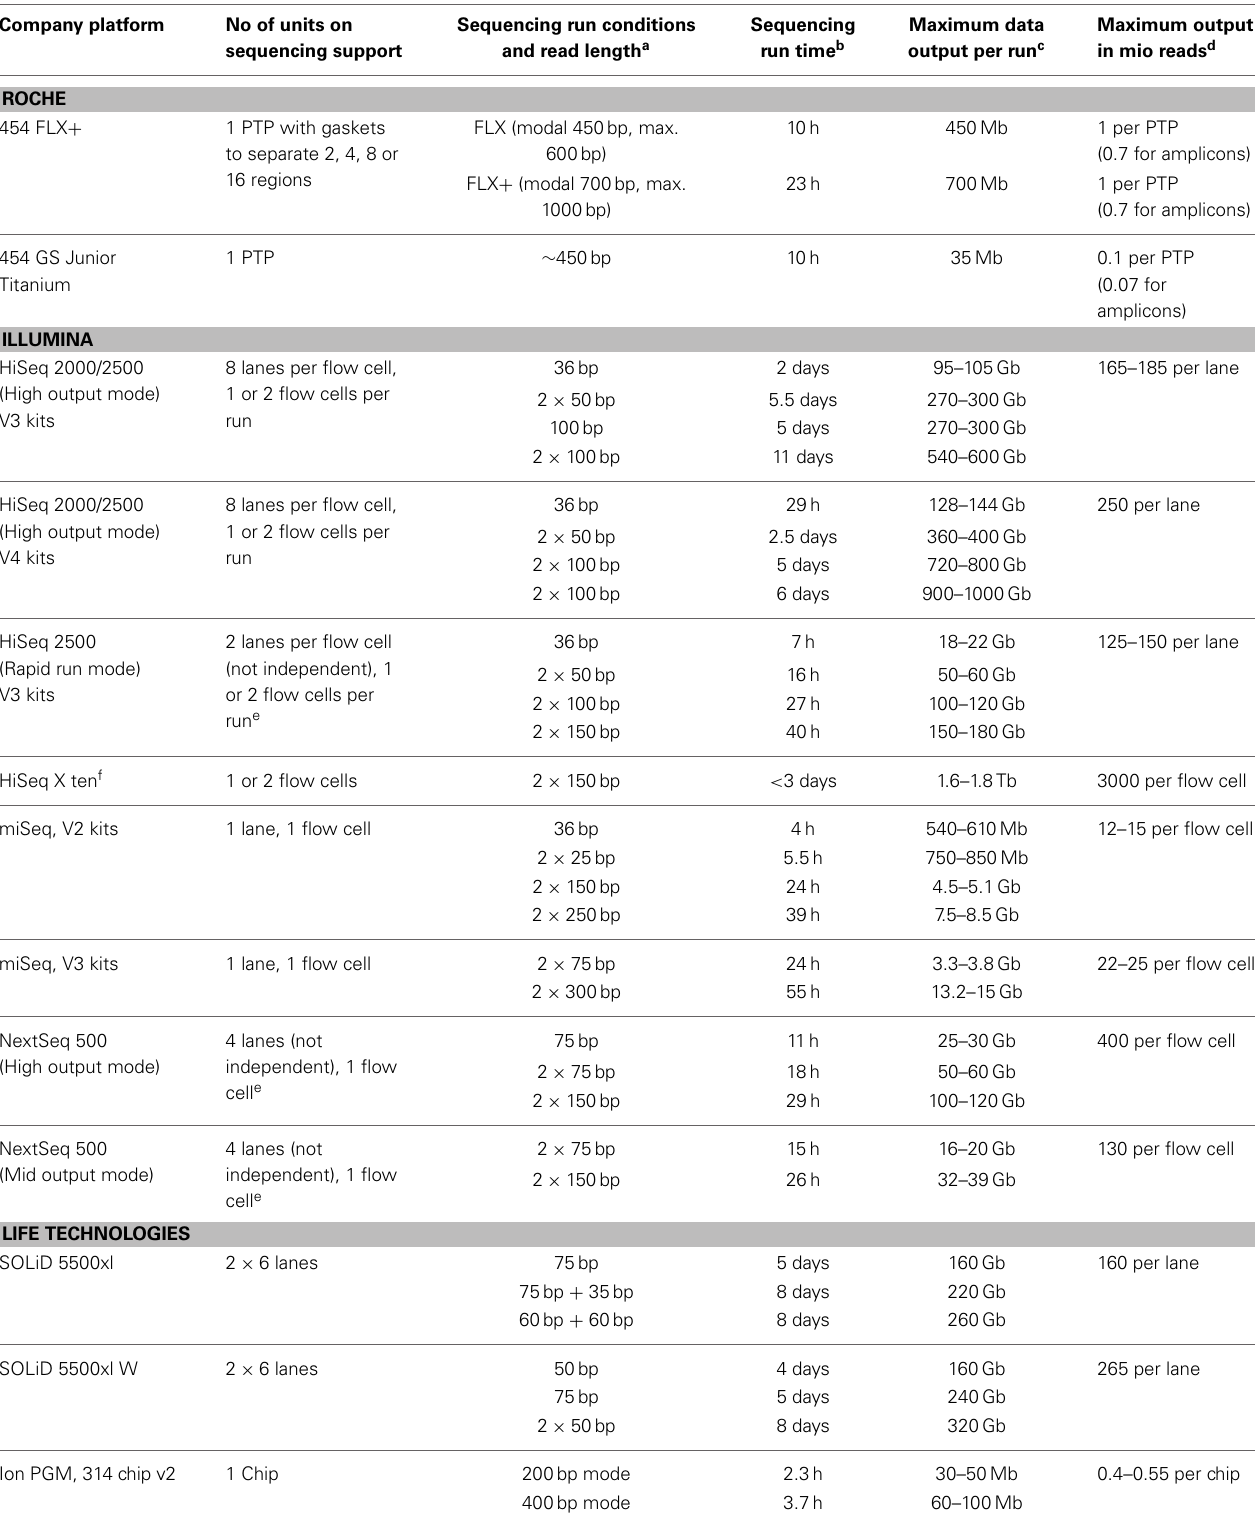
Table 2 | Data output of currently commercially available next generation sequencing platforms. Company